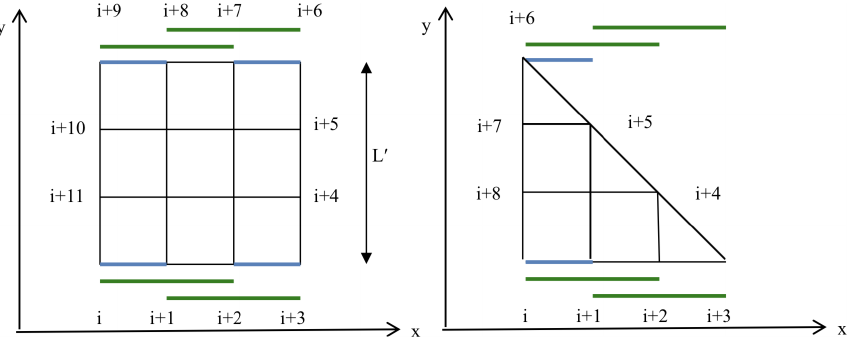
Figure 5. Derivation of equation 30 in the x direction for N = 3. Green and blue bars indicate terms to be considered in the derivation of Eqs. (28a) and (28b).